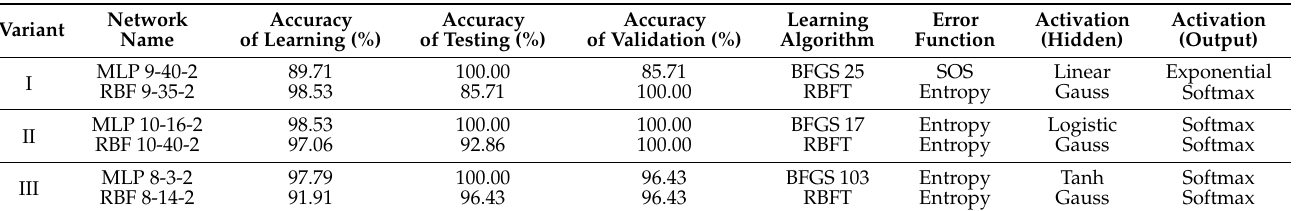
Table 2. Accuracy of the MLP and RBF neural network for variant I (open kinetic chain), II (closed kinetic chain), and III (open and closed kinetic chain).